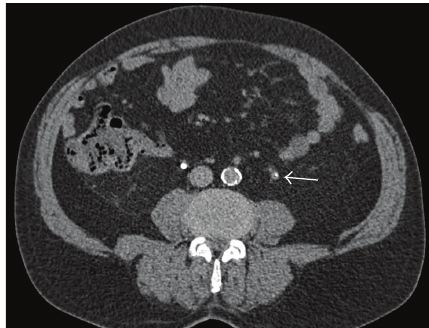
Figure 2: CT scan showing ureteral wall thickening with enhance- ment of contrast medium.